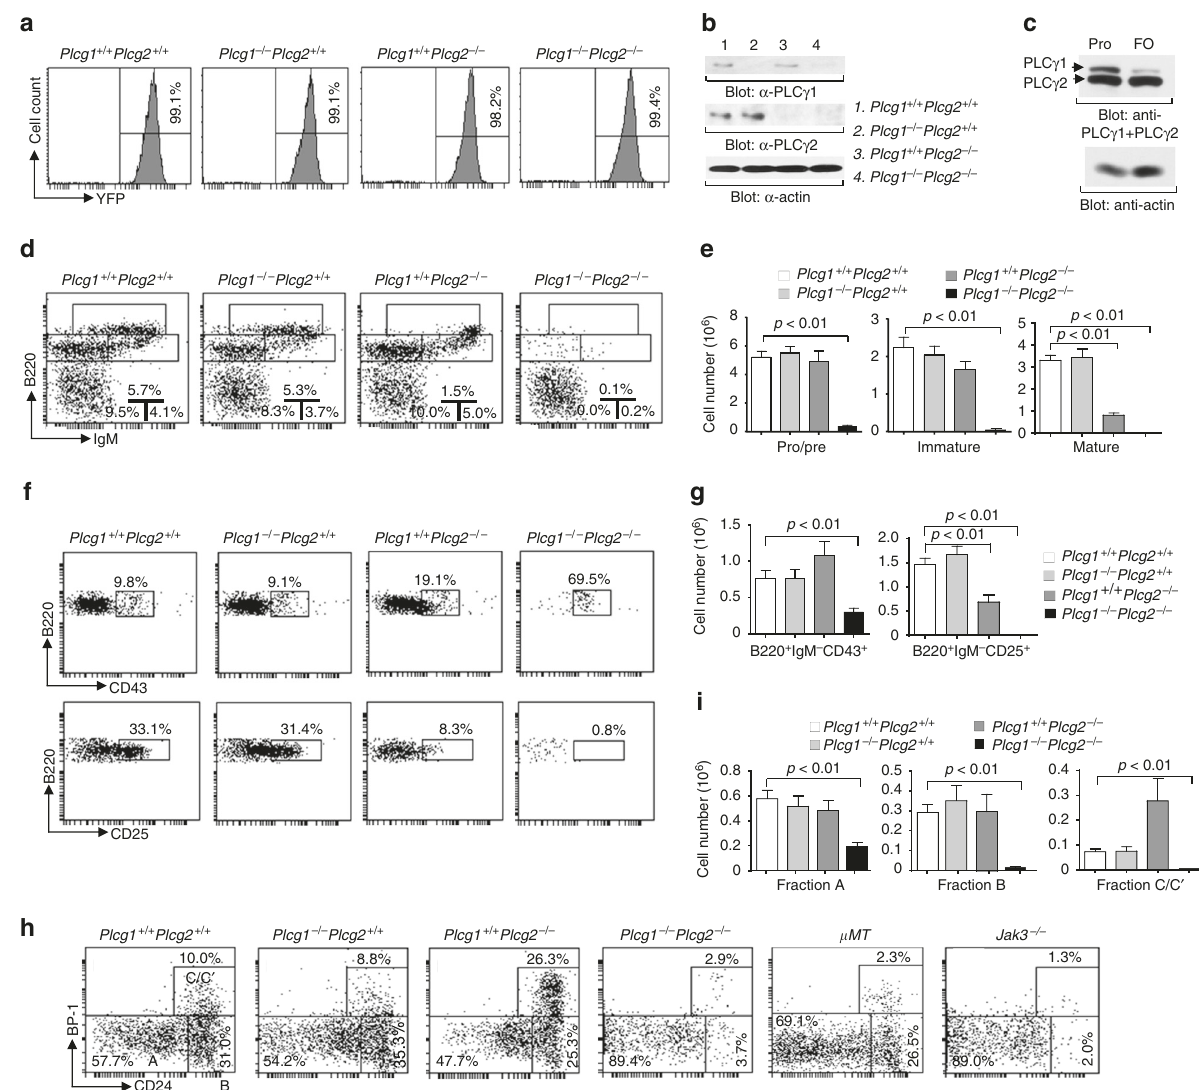
Fig. 1 PLC γ 1/PLC γ 2 double de fi ciency blocks B cell development at the pre-pro-B cell stage. BM from Plcg1 + / + Plcg2 + / + , Plcg1 − / − Plcg2 + / + , Plcg1 + / + Plcg2 − / − , or Plcg1 − / − Plcg2 − / − mice were transplanted into lethally irradiated congenic wild-type CD45.1 + mice. Six to eight weeks after transplantation, the recipients were analyzed. a BM cells from the recipients are largely YFP + donor-derived. Lin − CD45.2 + BM cells from the recipients were analyzed. Numbers indicate percentages of YFP + cells in the gated live cells. b Both PLC γ 1 and PLC γ 2 are deleted in YFP + BM cells from Plcg1 − / − Plcg2 − / − mice. YFP + BM cells from the recipients were subjected to western blot analysis. c Both PLC γ 1 and PLC γ 2 are expressed in pro-B cells. Sorted pro- (B220 lo IgM − CD43 + ) and FO (B220 + IgM lo CD23 + CD21 int ) B cells from wild-type mice were subjected to western blot analysis. d BM cells from the recipients were stained with anti-CD45.2, anti-B220, and anti-IgM. Numbers indicate percentages of pro/pre-, immature, and mature B cells in the gated CD45.2 + population. e Bar graphs show the numbers of CD45.2 + pro/pre-, immature, and mature B cells in BM. f BM cells from the recipients were stained with anti-CD45.2, anti-B220, anti-IgM, anti-CD25, and anti-CD43. Numbers indicate percentages of pro-B (upper) and pre-B (lower) cells in the gated CD45.2 + B220 + IgM − population. g Bar graphs show the numbers of CD45.2 + pro-B cells and pre-B cells in BM. h BM cells from the recipients were stained with anti-CD45.2, anti-B220, anti- CD43, anti-CD24, and anti-BP-1. BM from μ MT and Jak3-de fi cient mice served as the controls. Numbers indicate percentages of pre-pro-B (fraction A), early pro-B (fraction B) and late pro-B/early pre-B (fraction C/C ′ ) cells in the gated CD45.2 + B220 + CD43 + pro-B cell population. i Bar graphs show the numbers of CD45.2 + fractions A, B, and C/C ′ B cells in BM. Error bars show ± SEM. Data shown are obtained from or representative of 10 ( a , d – g ) or 8 ( h , i ) mice of each genotype or representative of 2 ( b , c ) independent experiments. Control data are representative of 3 μ MT and Jak3-de fi cient